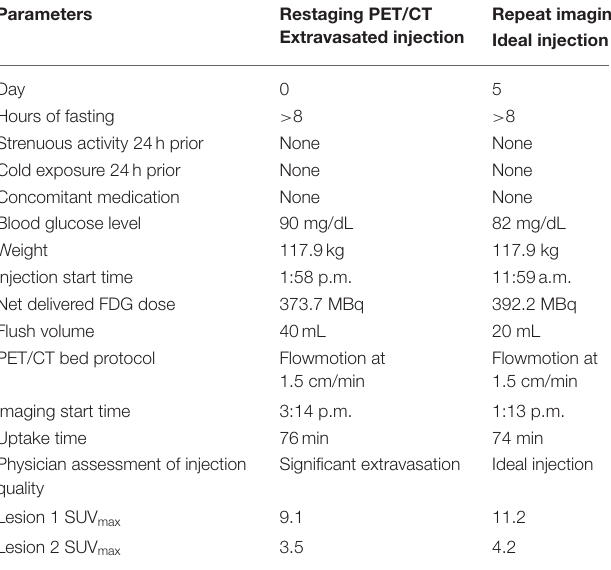
TABLE 7 | Procedure parameters for Patient E.